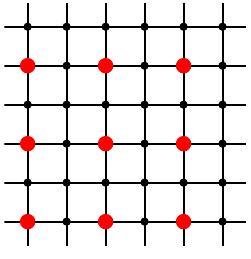
Figure 22: Red dots represent the set of sites on which the operator ˆ O from Eq. 19 is defined. Each 1 × 1 plaquette touches exactly one red site. Such a set exists only if N , N are both x y